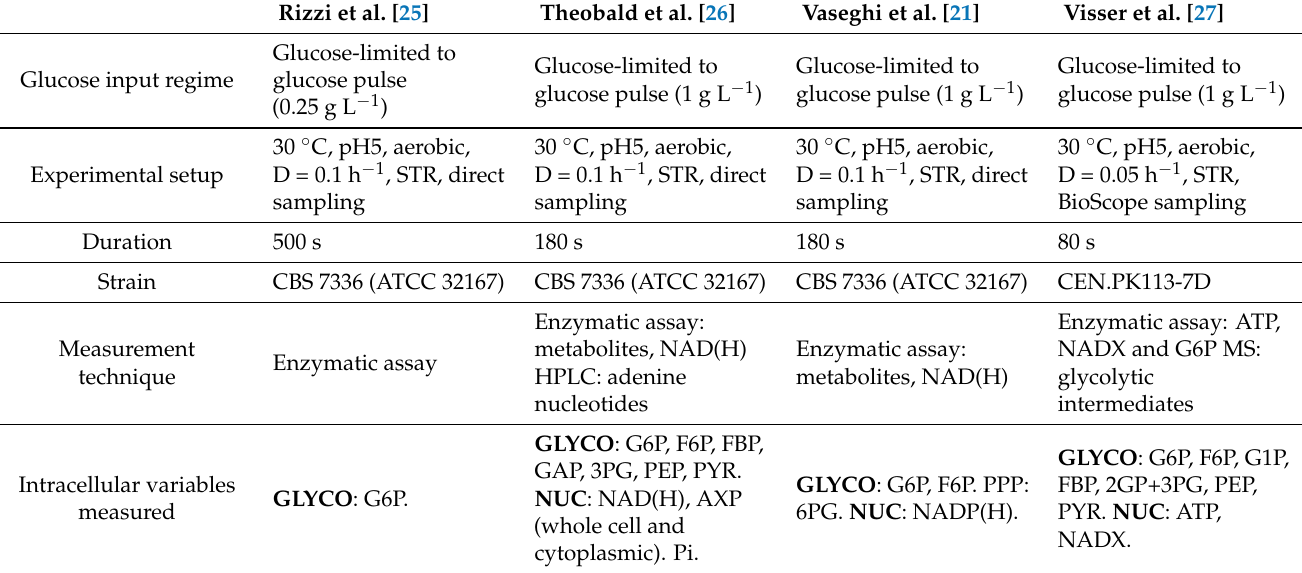
Table 2. Glucose perturbation experiments in S. cerevisiae with intracellular metabolome quantifi- cation: Stirred tank reactors (STR) operated in chemostat. Shake flasks (SF) in batch